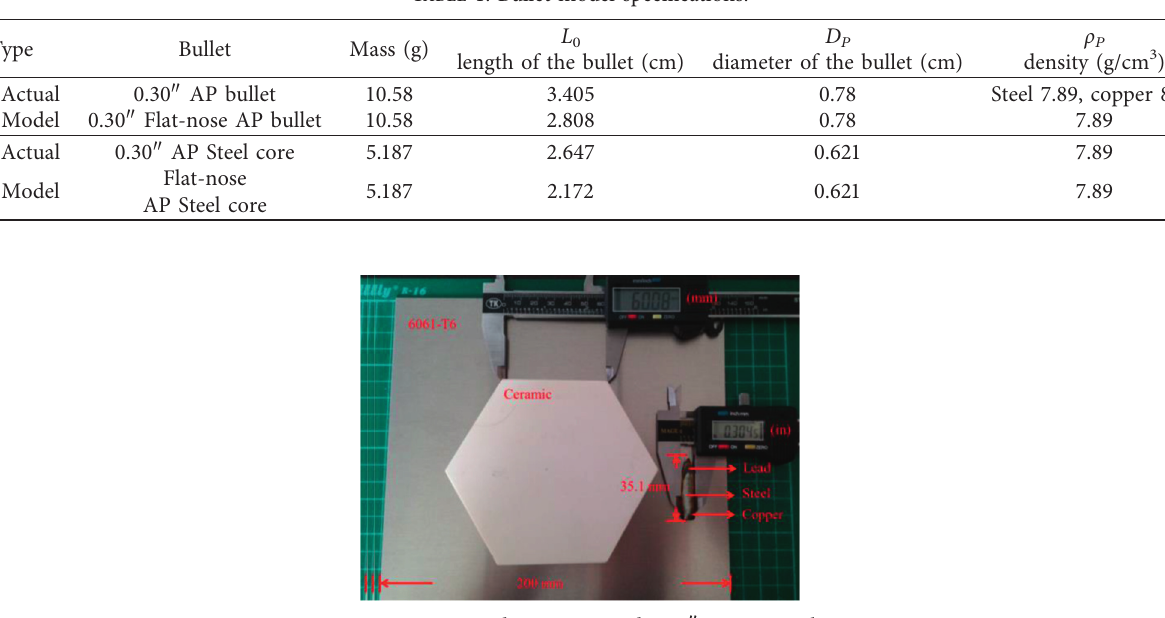
Table 1: Bullet model specifications.